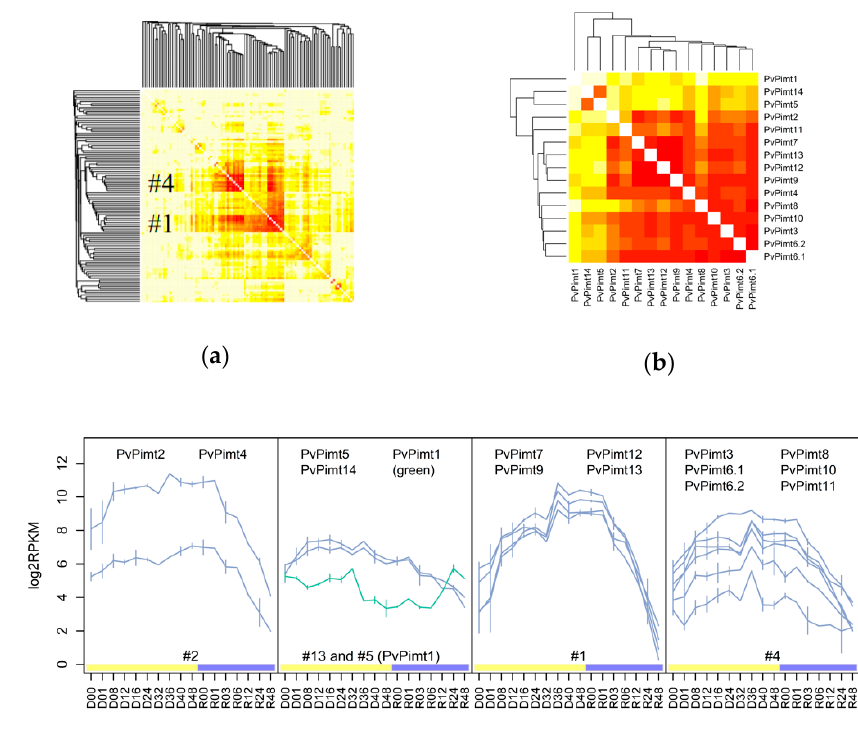
Figure 2. Co-expression network for P. vanderplanki SAM methyltransferases. ( a ) General view on the network, including all Pv SAM MTases . ( b ) PvPimt genes co-expression heatmap. ( c ) PvPimt expression profiles by WGCNA cluster. D00—control, D01–D48—desiccation for 1–48 h (yellow bar), R00–R48—rehydration samples for 0–48 h (blue bar).